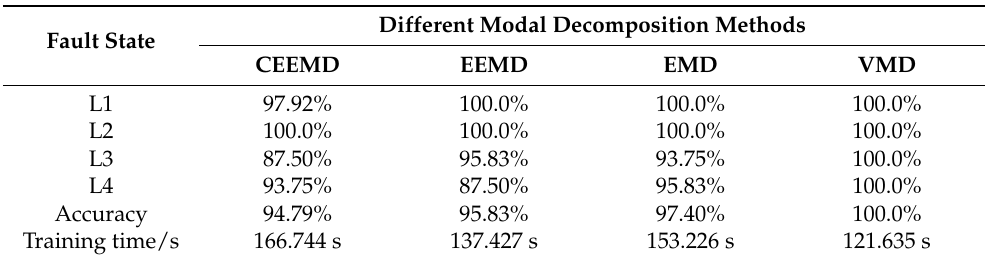
Table 8. The results of the contrastive analysis of the various mode decomposition